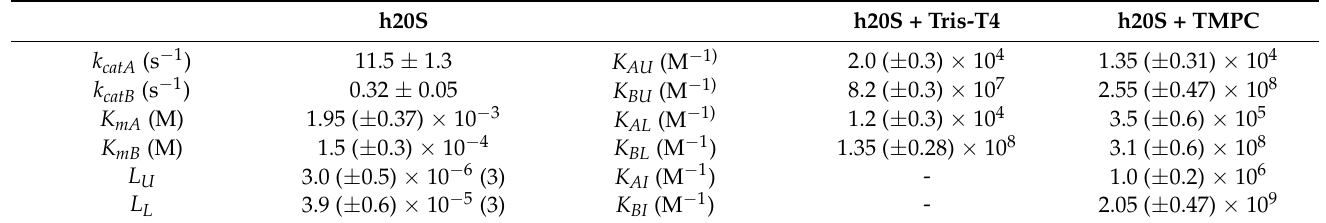
Table 1. Parameters for the comparison of catalytic parameters for Tris-T4 and TMPC porphyrins on h20S according to Equation